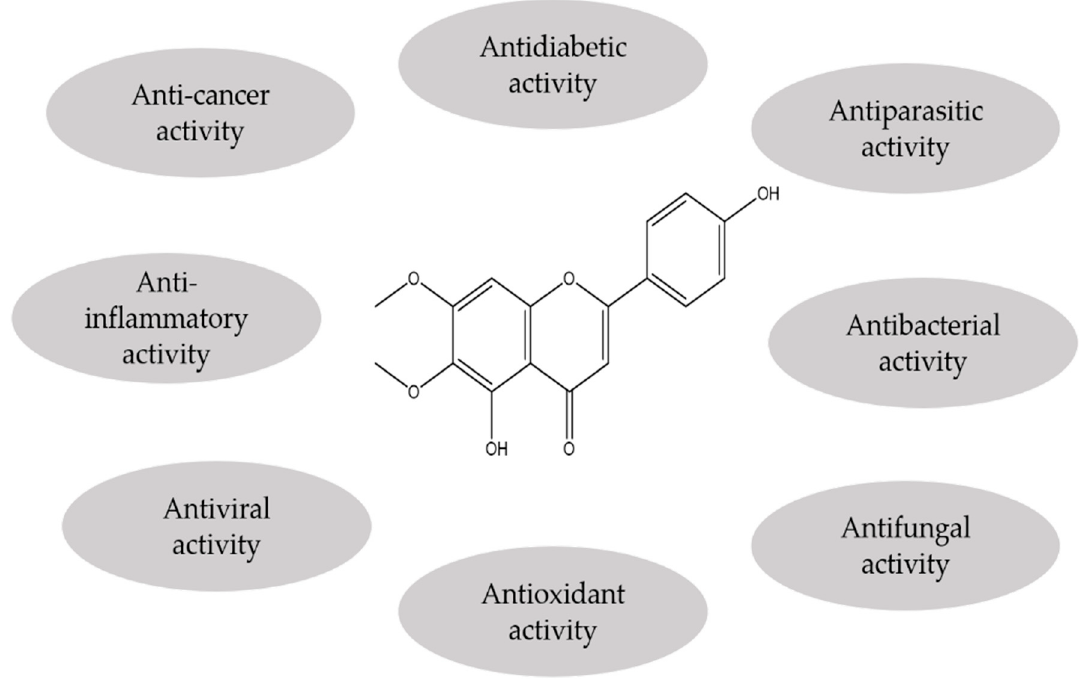
Figure 2. Different biological and pharmacological properties induced by cirsimaritin. Table 2. Antibacterial and antifungal effects of